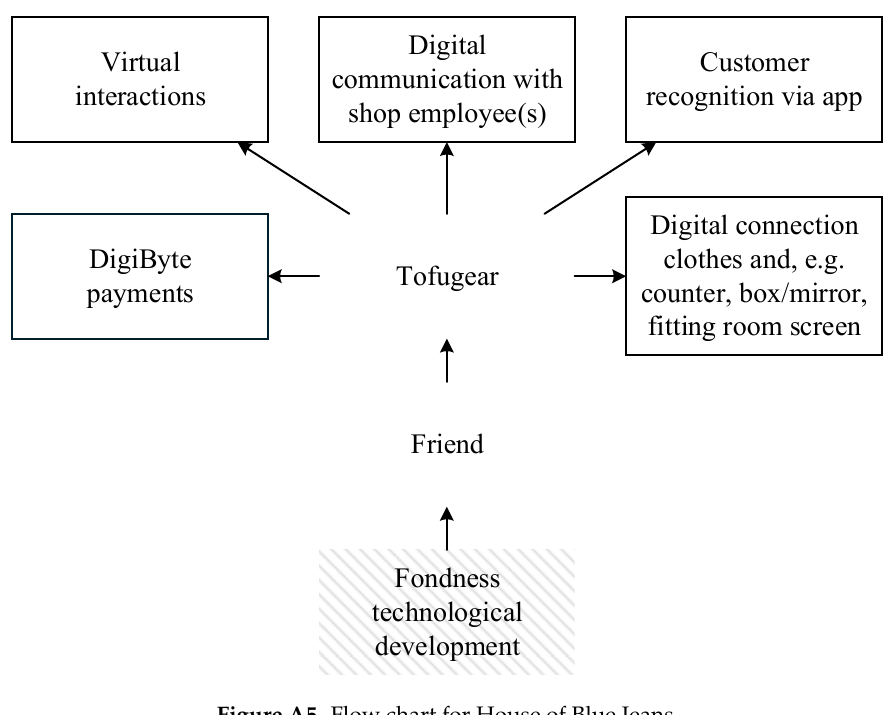
Figure A4. Flow chart for GS Metaal.